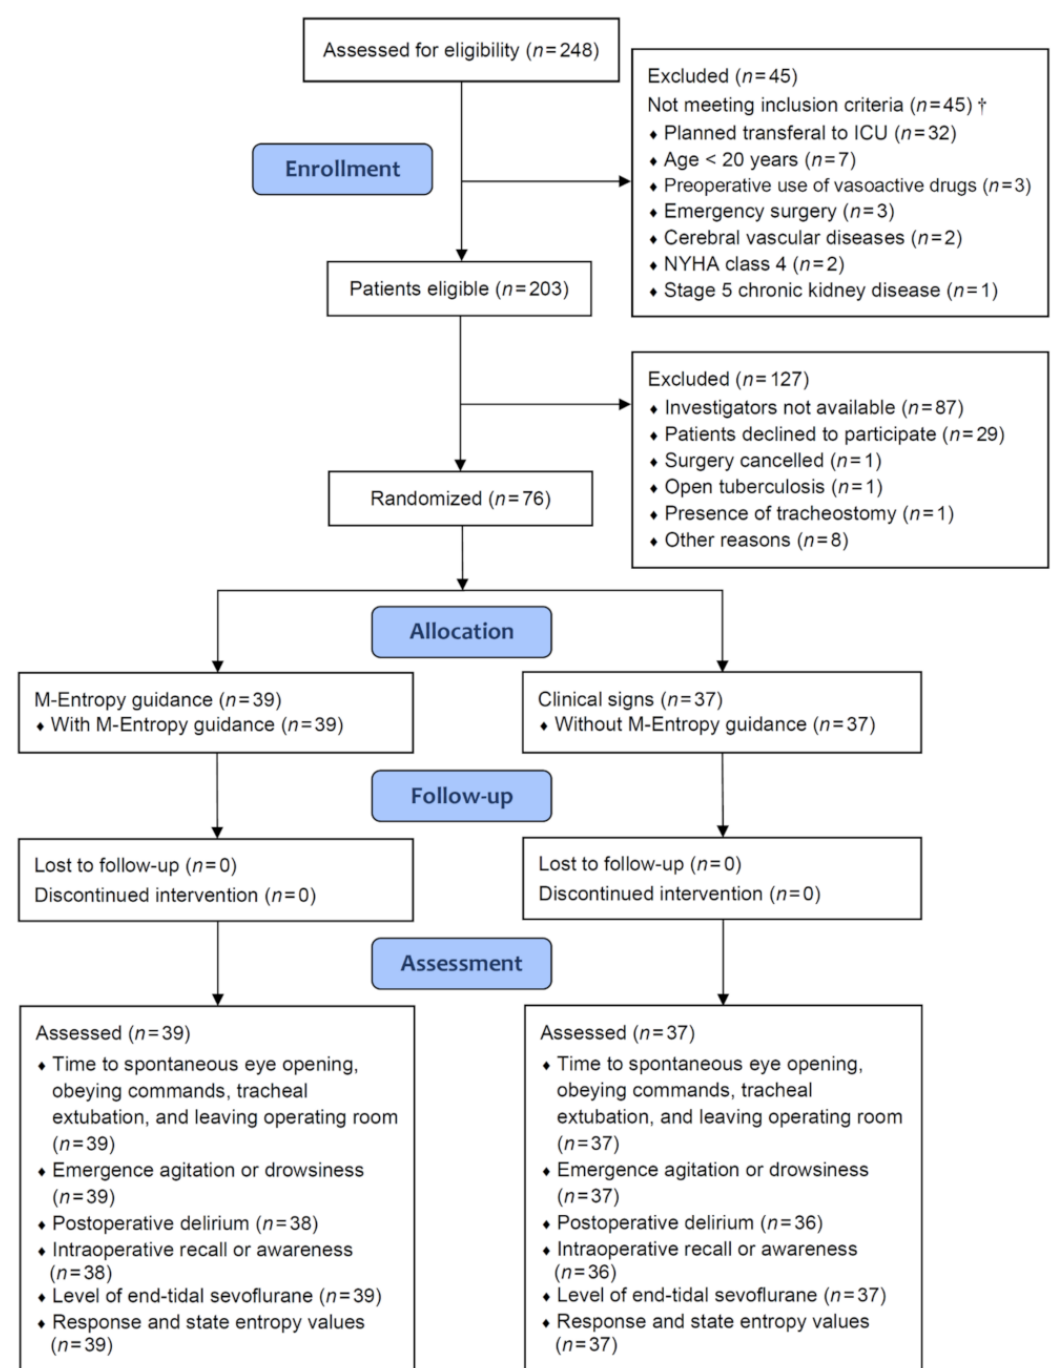
Figure 1. Consolidated Standards of Reporting Trials flow diagram. † Not mutually exclusive because patients can have more than one exclusion